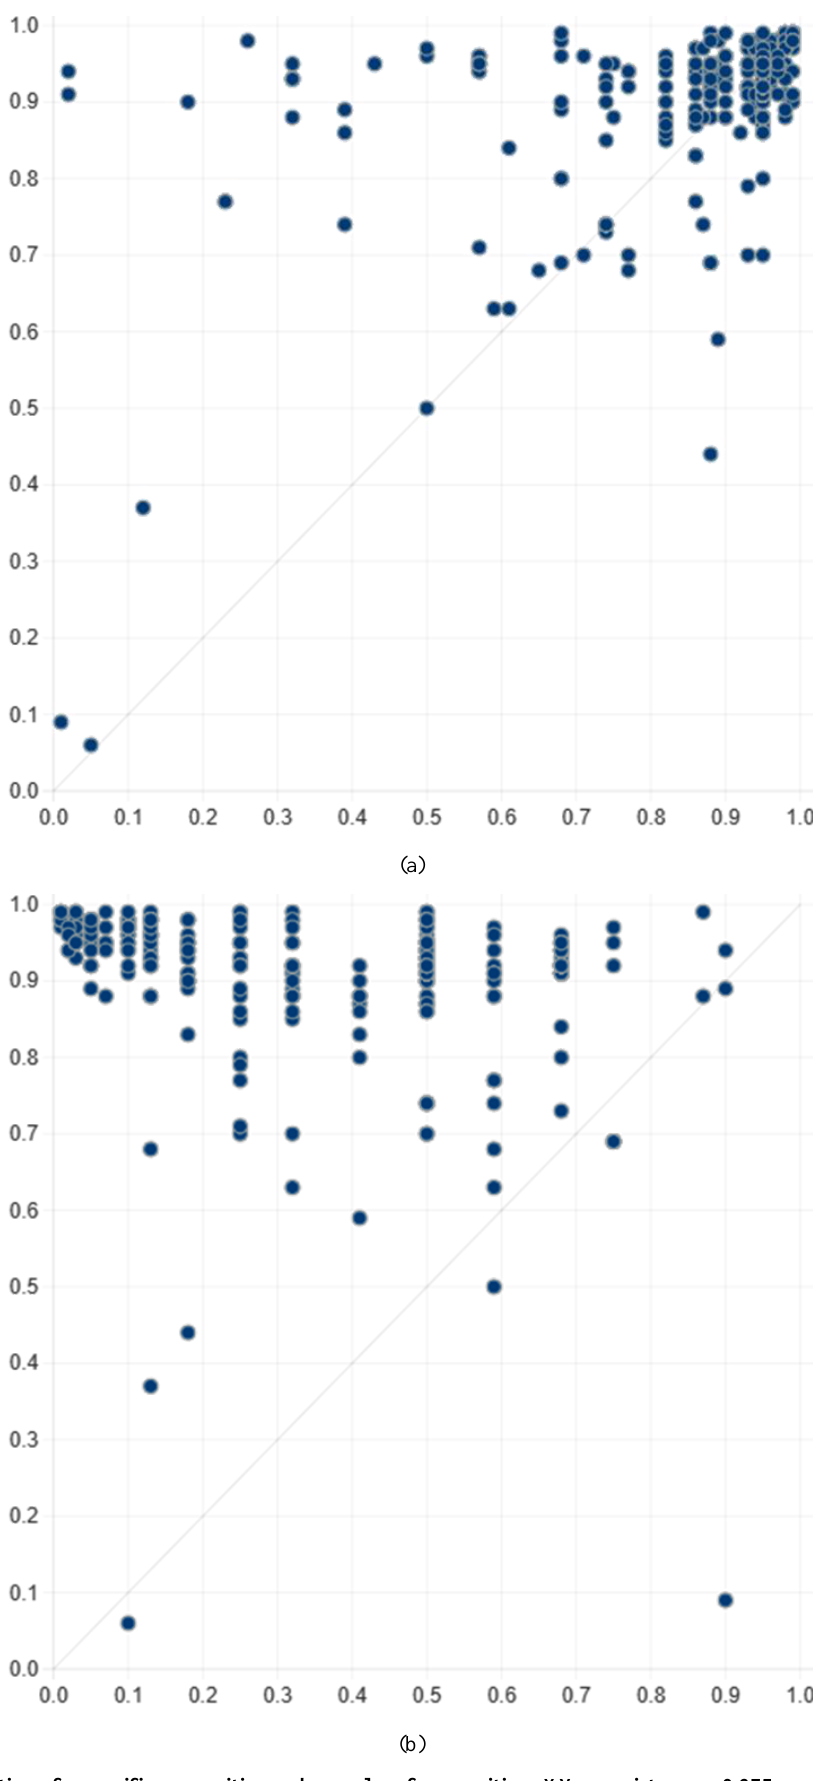
Figure 3. (a) Plotting of a specific proposition, subsamples of propositions XY: consistency = 0.975, coverage = 0.936; (b) Fuzzy-plot of model 1 using data from holdout sample: consistency = 0.991, coverage = 0.419